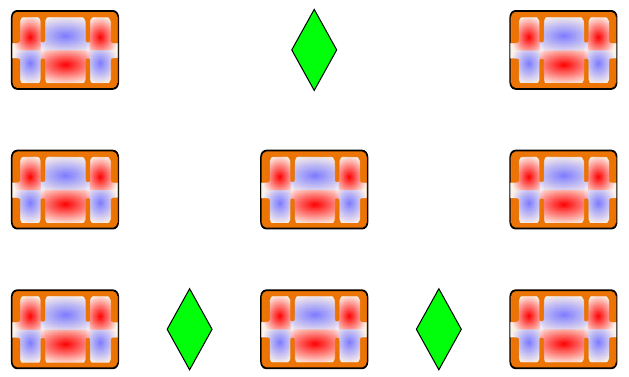
FIG. 4. Three different configurations provide time-transverse coupling-based